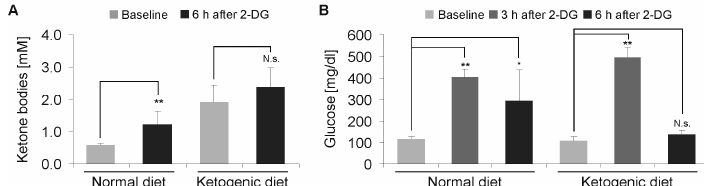
Figure 4. Effects of 2-deoxyglucose on blood ketone bodies and glucose levels. ( A ) Mice were fed either normal diet or ketogenic diet. Following intraperitoneal injection of 4 g 2-DG, the blood ketone bodies were determined after 6 h ( n = 8, mean + standard deviation, not significant (N.s.) p > 0.05, ** p < 0.01, Student’s t -test). ( B ) Mice were fed either a normal diet or ketogenic diet. Following the intraperitoneal injection of 4 g 2-DG, the blood glucose was determined after 3 and 6 h ( n = 8, mean + standard deviation, N.s. p > 0.05, * p < 0.05, ** p < 0.01, Student’s t -test).